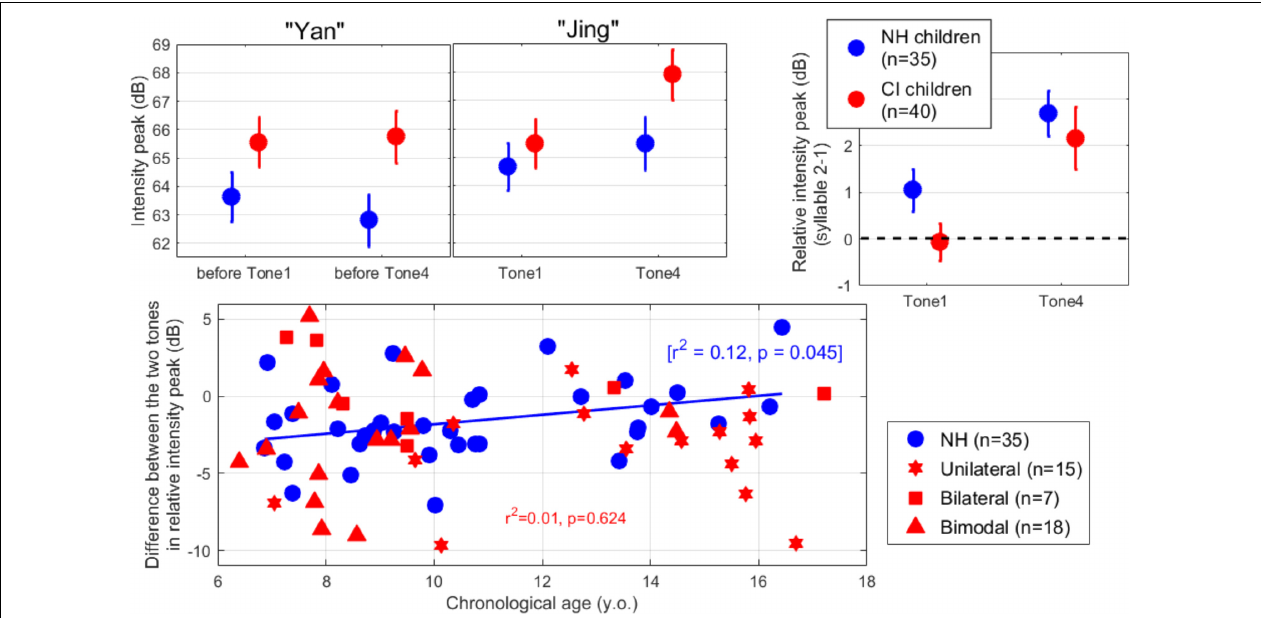
FIGURE 4 | (Top-left) Intensity peak of the first and second syllable of the word “yan-jing” spoken as Tone 1 or Tone 4, averaged across all participants in each population. (Top-right) Intensity peak of each tone relative to the syllable preceding it. All children tended to soften the intensity of Tone 1 relative to Tone 4. (Bottom) Difference in relative intensity peak between the two lexical tones, plotted across participants as a function of their chronological age. A lower negative value is indicative of a stronger tendency to soften Tone 1 relative to Tone 4.